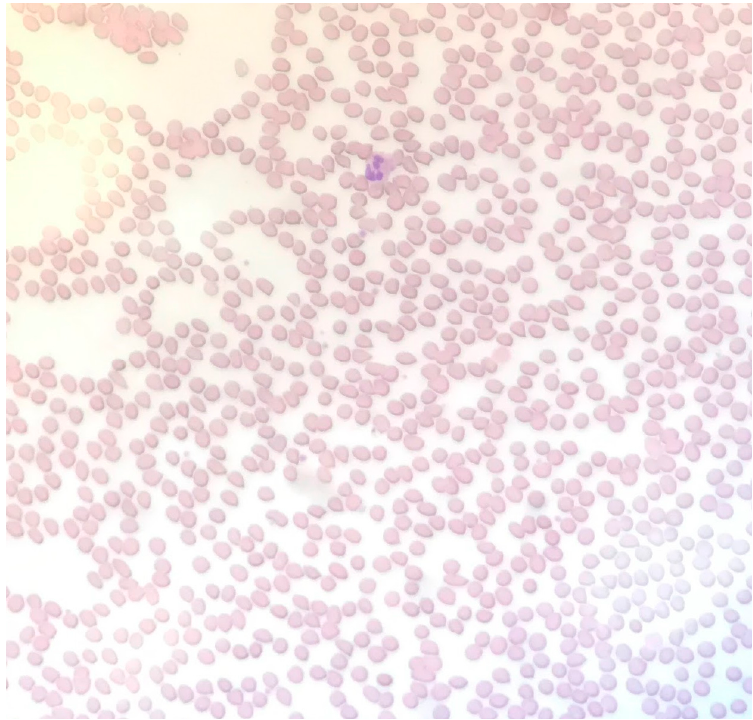
Figure 2. Peripheral smear showing no signs of pathognomonic schistocytes.